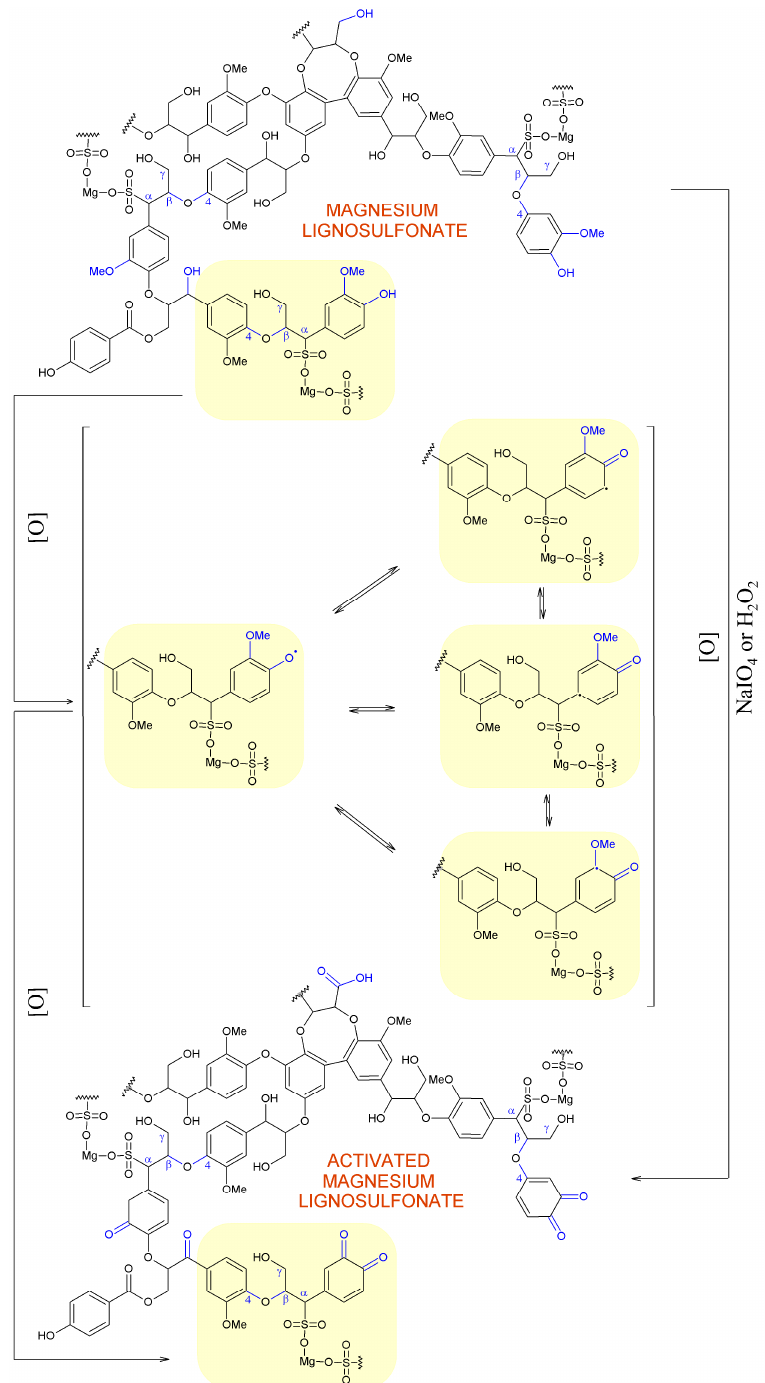
Figure 4. Proposed mechanism of activation of magnesium lignosulfonate using NaIO 4 and hydrogen peroxide.